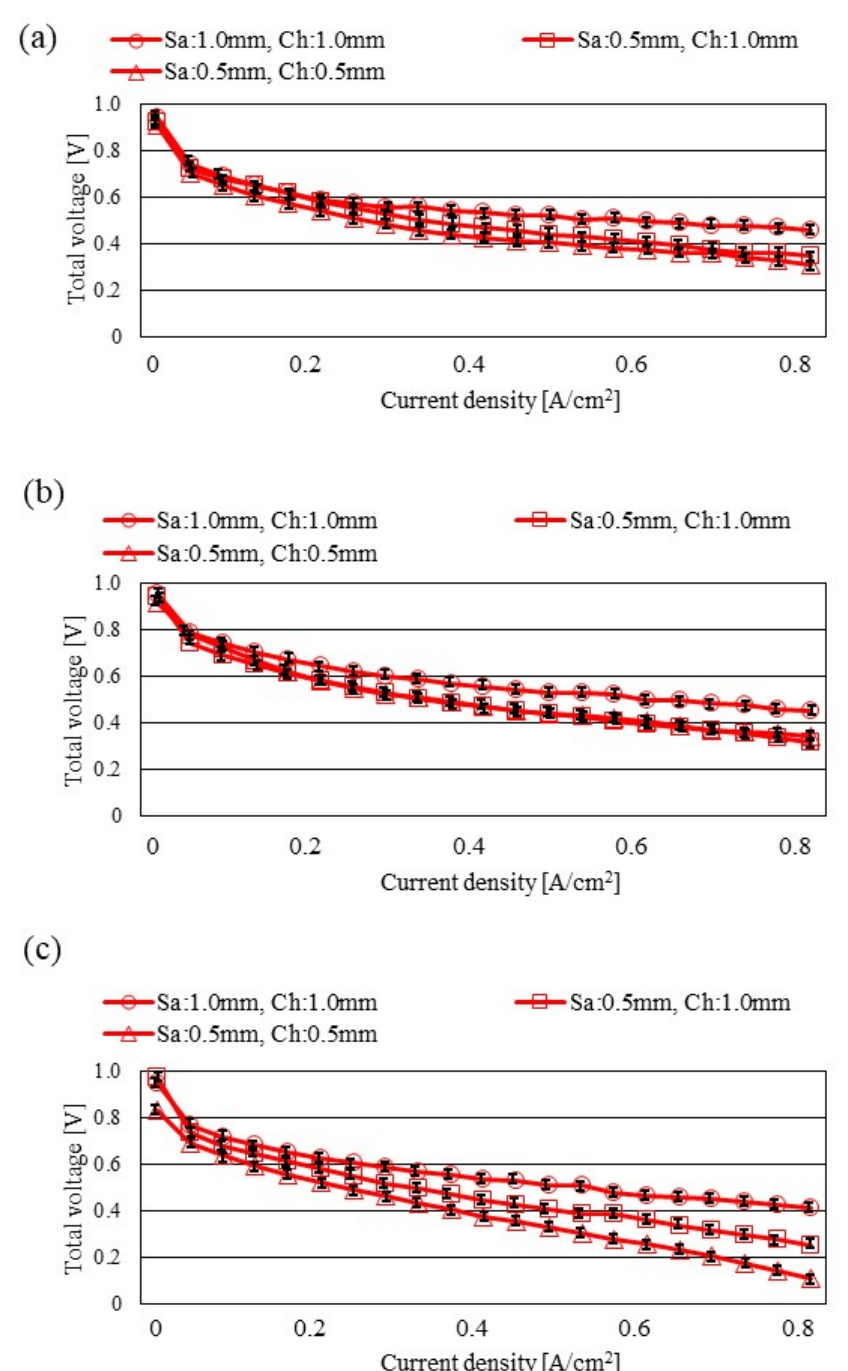
Figure 8. Comparison of polarization curves among different separator thicknesses with A40%RH&C40%RH: ( a ) T init = 353 K; ( b ) T init = 363 K; ( c ) T init = 373 K.